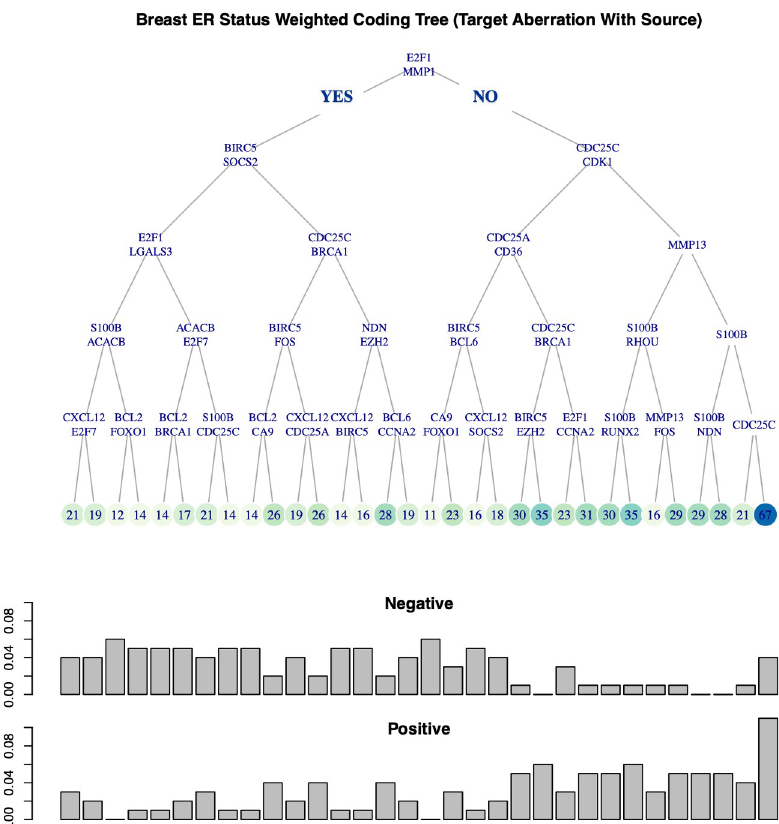
Fig 6. Coding tree for breast ER status at target level. For Breast tumor samples, a weighted coding tree T with depth d = 5 is constructed using one covering at target level. At each internal node, a sample is sent to the left if the indicated two genes at the node are both RNA aberrant with some aberrant source, whereas it is sent to the right otherwise. Sample counts for each terminal nodes are indicated and highlighted using a green palette. The two histograms at the bottom show the sample distribution at the 32 terminal nodes for the ER negative and ER positive sub-populations.